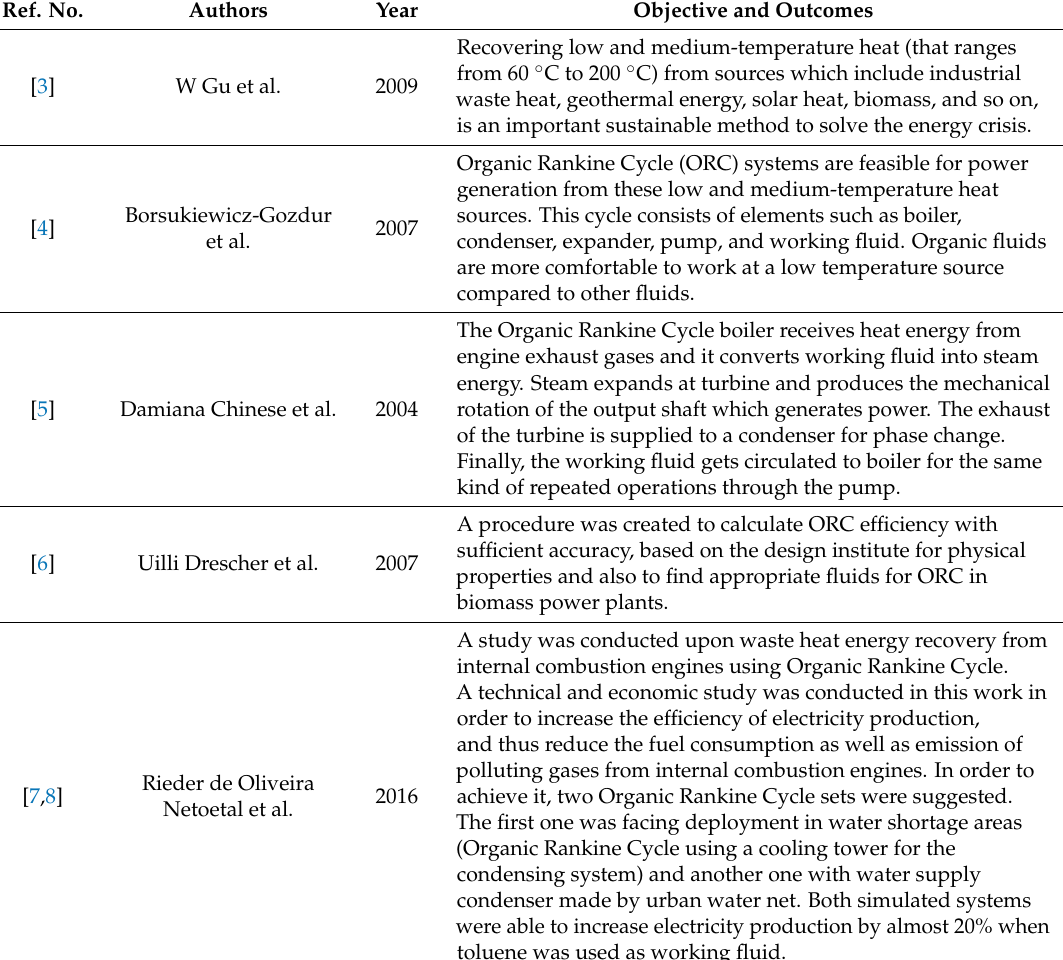
Table 1. Literature summary of closely related